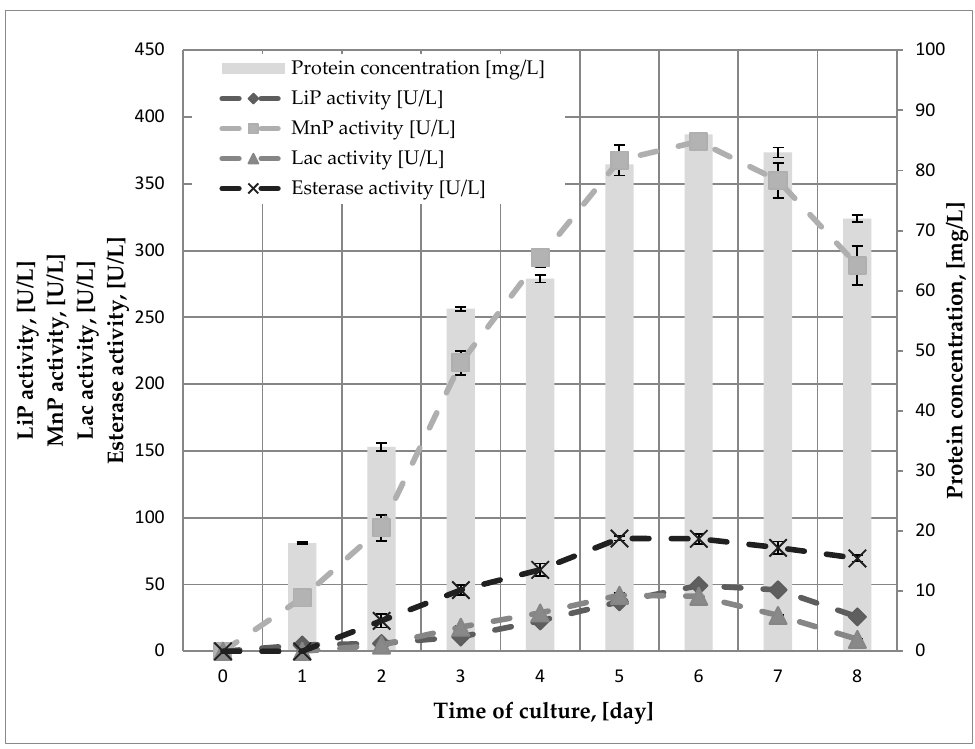
Figure 3. The activity of extracellular enzymes and the protein concentration of B. adusta DSM 3375 during 8 ‐ day cultivation.